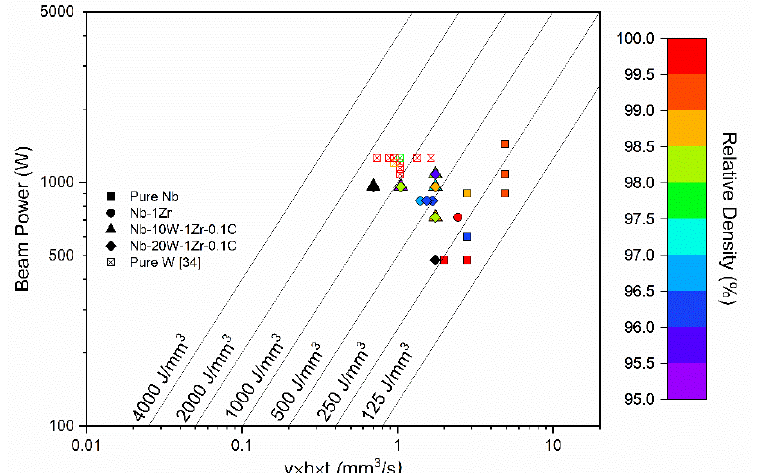
Figure 6. Process map for Nb-W alloys in comparison to pure Nb and pure W.